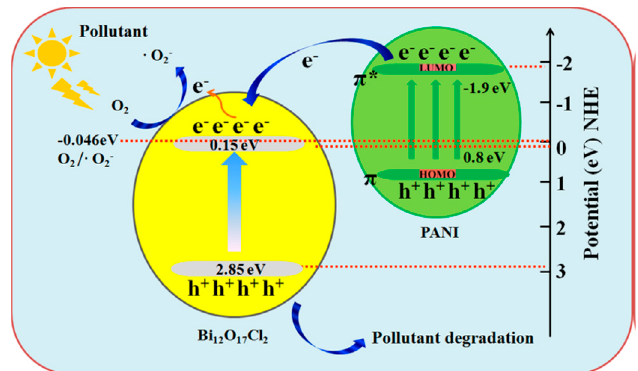
Figure 2. Proposed mechanism for photocatalytic degradation reaction under visible light irradiation by PANI/Bi 12 O 17 Cl 2 composite photocatalysts [17].